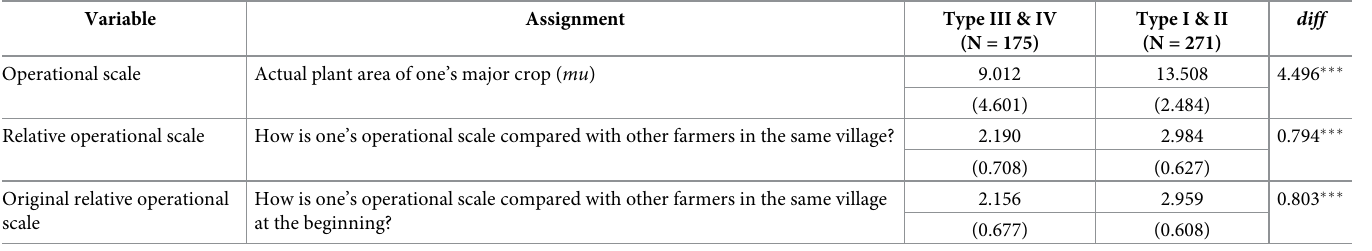
Table 3. Comparison of farmers’ operational